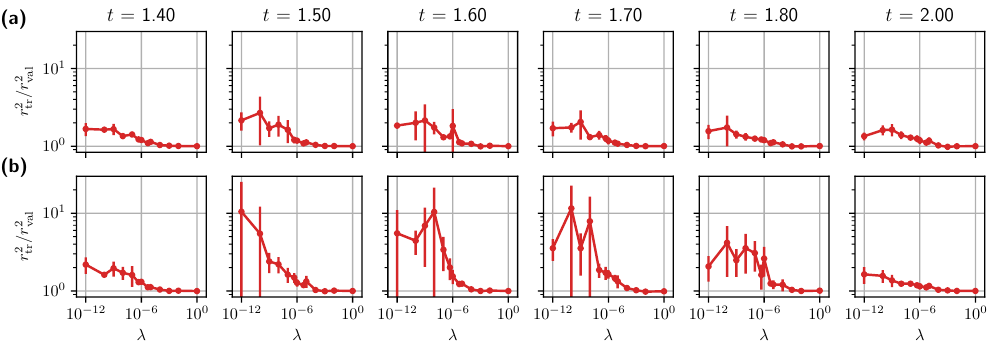
Figure 11: Validation error relative to the TDVP error for the data shown in Fig.